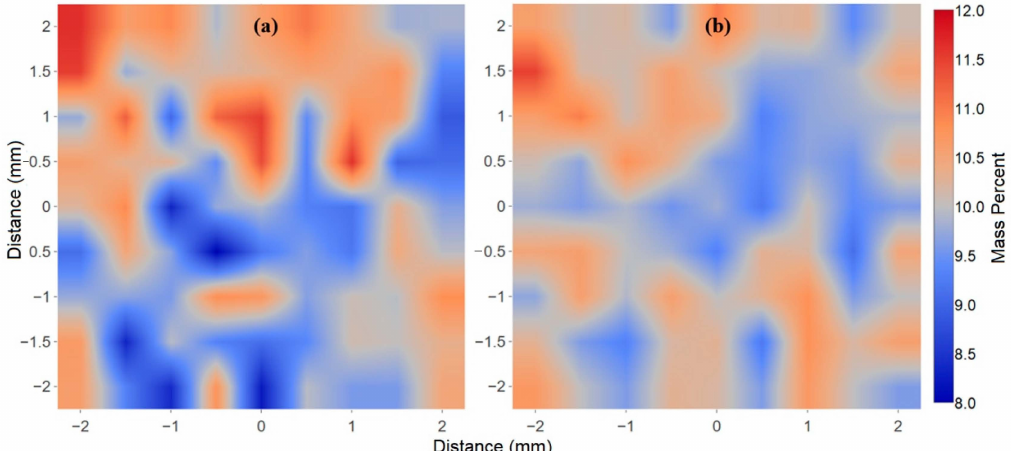
Figure 2. False color heat maps showing the loratadine mass percent (blue = 8%, red = 12%) for a 9 × 9 point grid covering a 4 × 4 mm 2 surface section to a depth of ~1 mm of a Claritin tablet using 81 Raman spectra determined by ( a ) the 1630 cm − 1 peak height (baseline corrected) and ( b ) the weighted percentage, 1st-derivative, 200–1800 cm − 1 , spectral fits using pure loratadine, lactose monohydrate and cornstarch. Spectral conditions: 275 mW at 1064 nm, 10 averaged, 4-s integrations/spectrum (total time at 40 s/spot was ~1